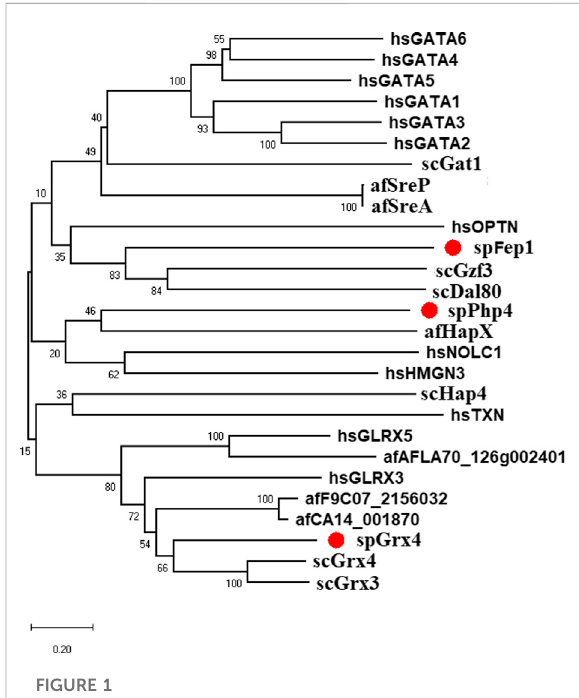
FIGURE 1 Bayesian evolutionary tree of spGrx4, spFep1, and spPhp4 and their sequence homologs in A. fl avus, S. cerevisiae , and humans. spGrx4, spFep1, and spPhp4 are colored red. In the analysis, the strict clock model was implemented. Using the MCMC algorithm, the trustworthiness of phylogeny nodes was assessed. At the nodes, Bayesian posterior probabilities are displayed. The scale bar indicates that there are 0.2 amino acid substitutions at each